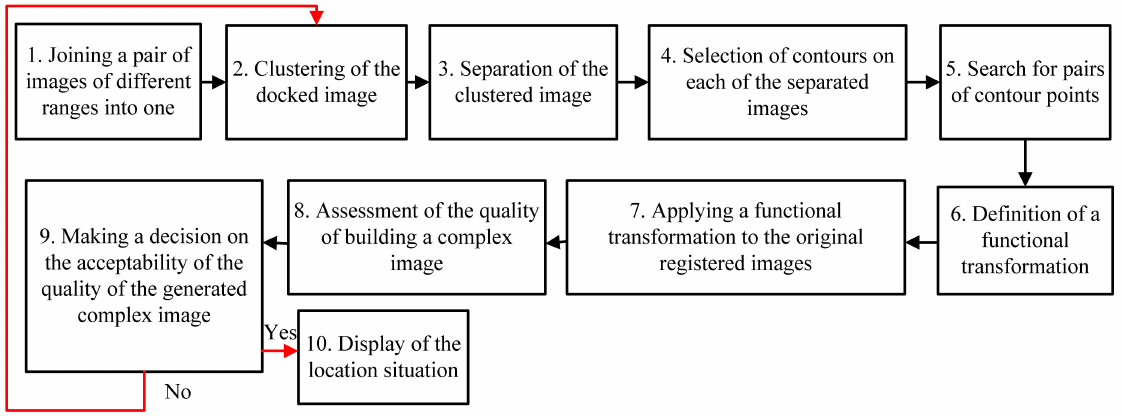
Figure 2. Scheme of implementation of the method for fused image